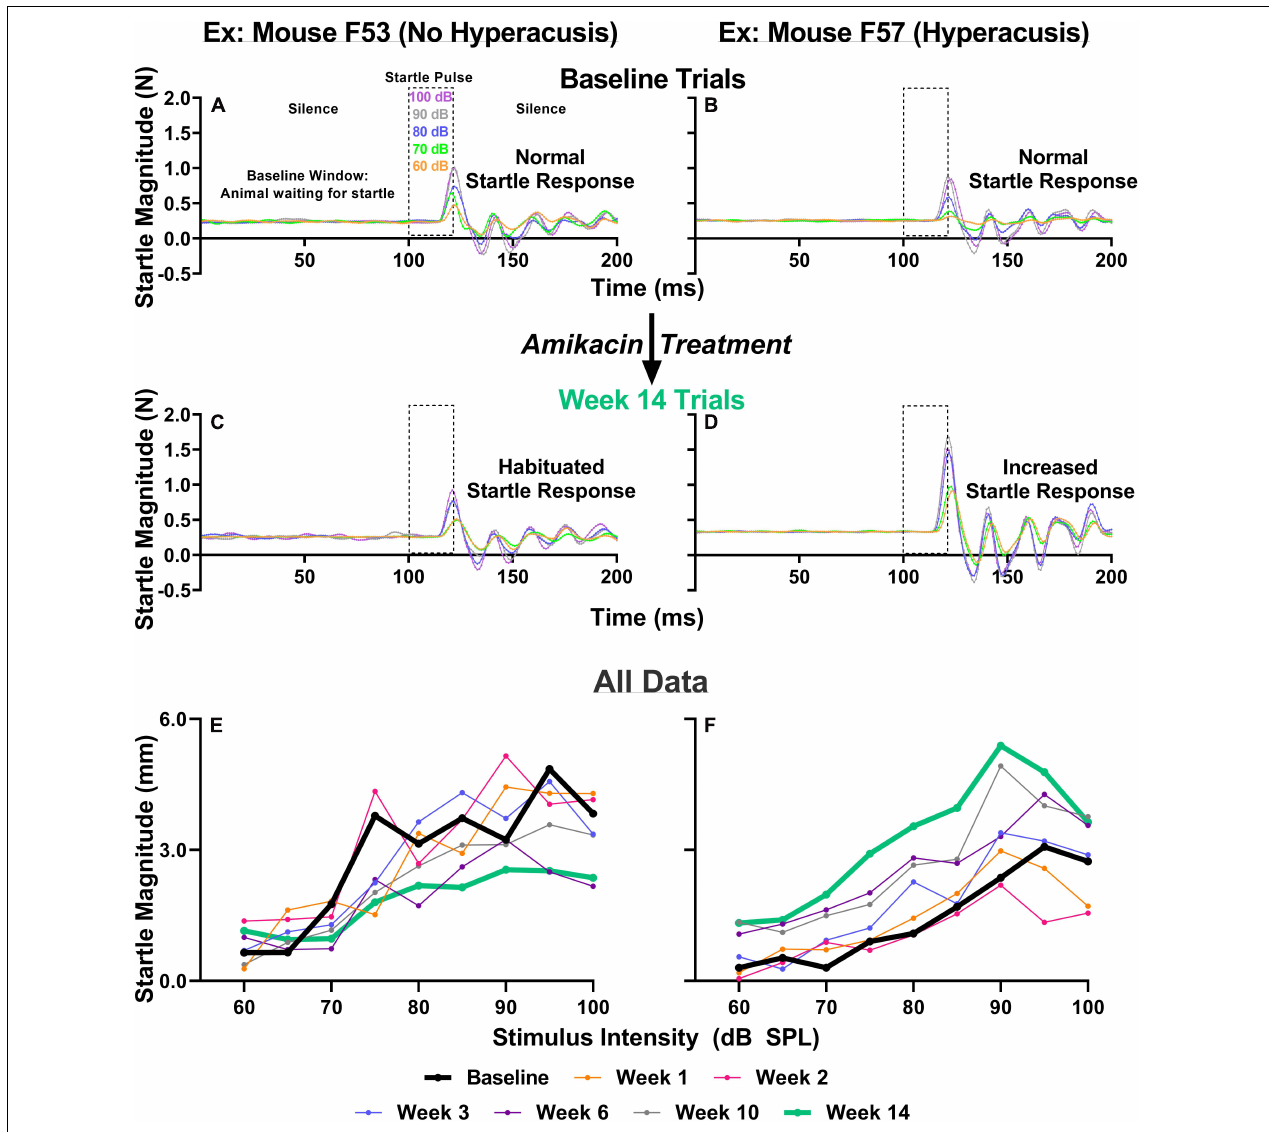
FIGURE 5 | (A–D) IO paradigm, including the stimuli used and the corresponding animal reactions. Representative baseline IO trial data (five trials; one trial each for startle pulses presented at 60, 70, 80, 90, and 100 dB SPL) from two representative animals (A,B) . Representative 14-week post amikacin treatment IO trial data from an animal who did not develop hyperacusis (C) and from an animal who did develop hyperacusis (D) . The resulting startle response wave forms are color-coded to the level of startle stimuli presented. (E,F) All IO Startle stimulus/response functions recorded from the two representative mice (from A–D ). Startle response magnitude means are plotted as a function of stimulus intensity (60 to 100 dB SPL in 5 dB steps) and colored-coded based on specific testing epochs {baseline, 1, 2, 3, 6, 10, and 14 weeks}. Notice the differences between the bolded black lines (baseline; A,B ) and bolded green lines (week 14; C,D ) from the animal without hyperacusis (C) , compared to the animal with hyperacusis (D) . Startle Magnitude recorded via force (N) in (A–D) was converted to CMD (mm) in (E,F)